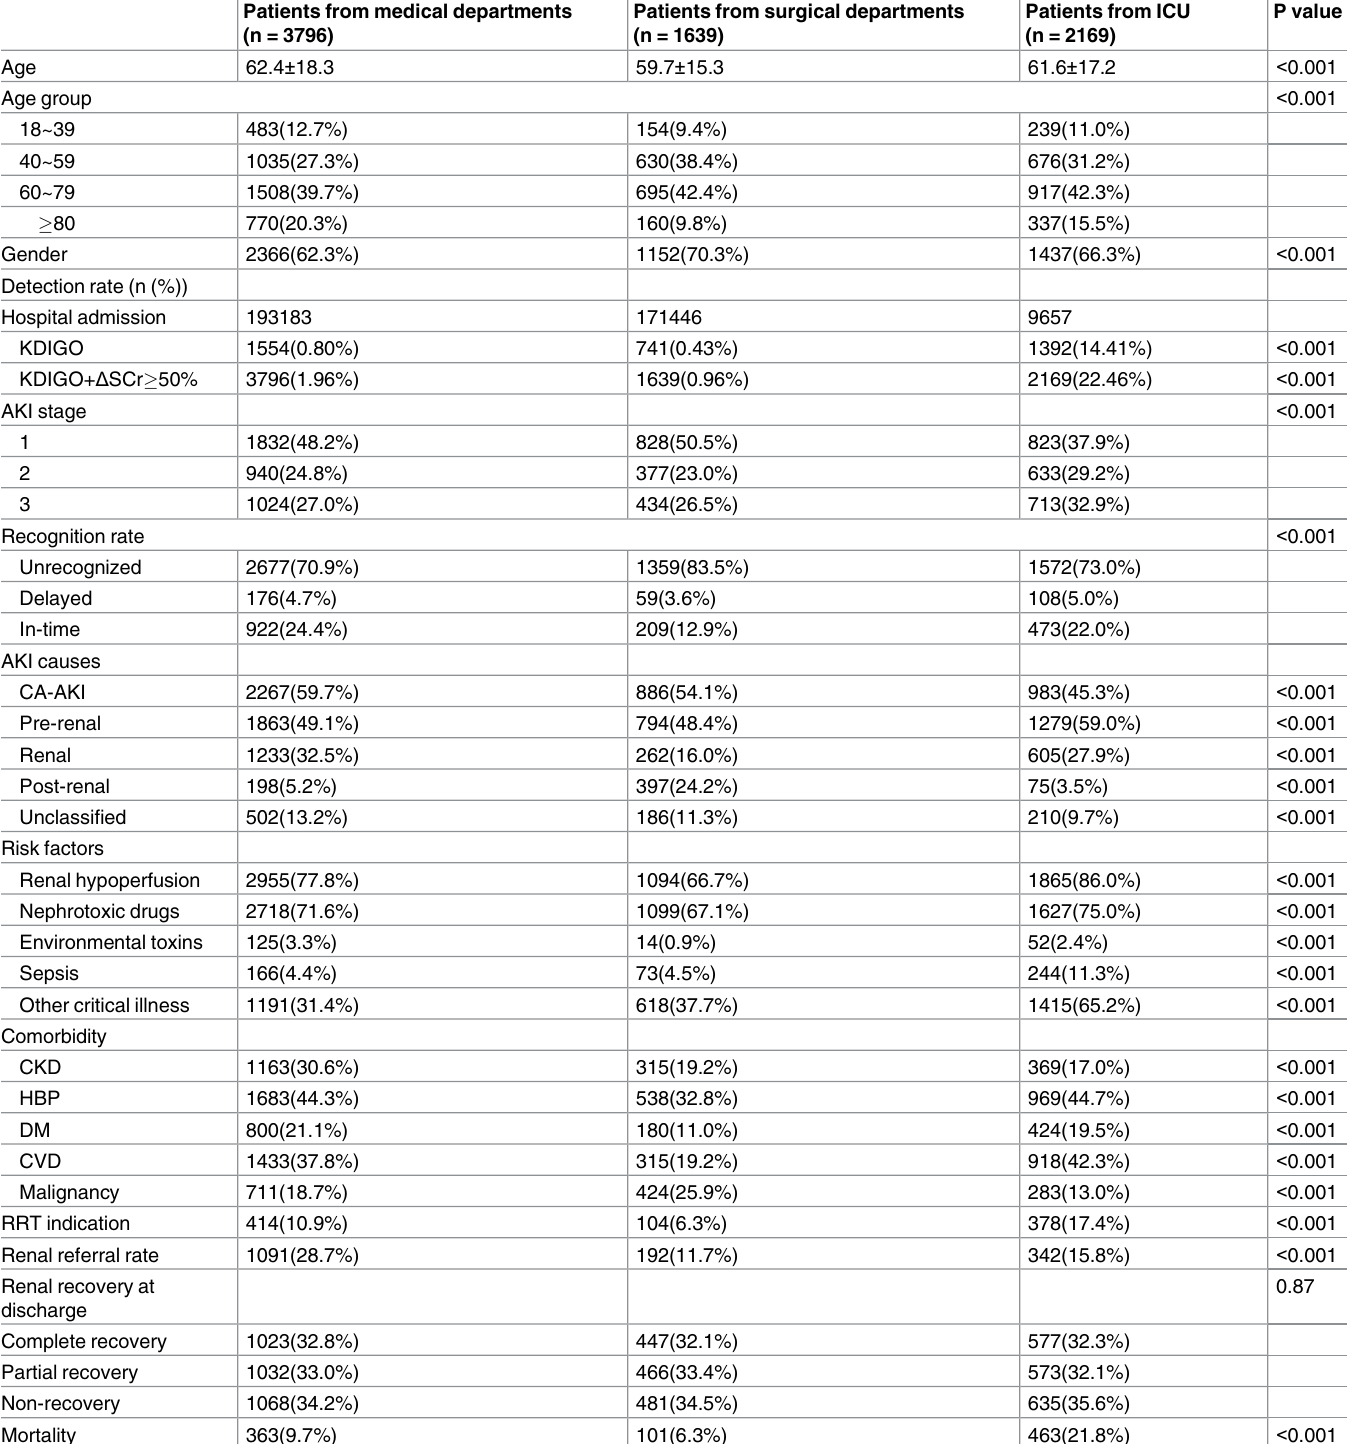
Table 1. The detection rates of AKI and characteristics of patients in medical, surgical and ICU departments *